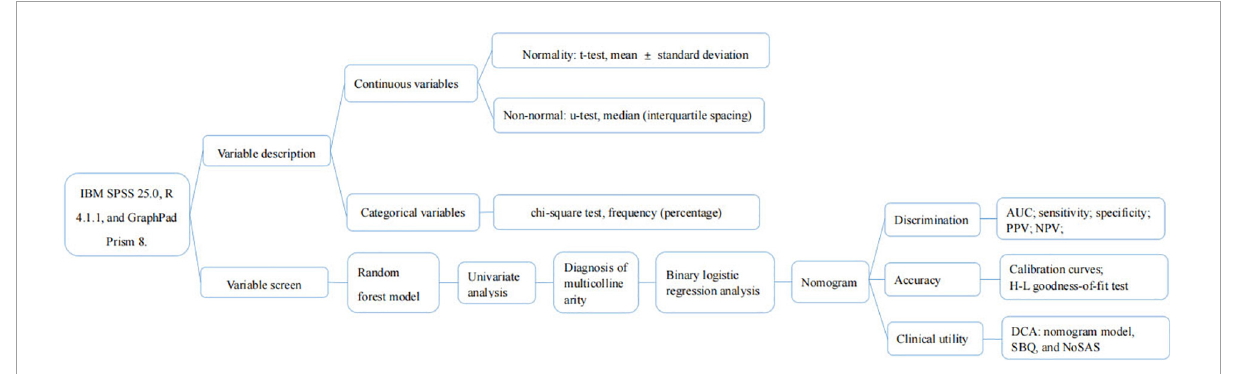
FIGURE1 Flow chart of statistical